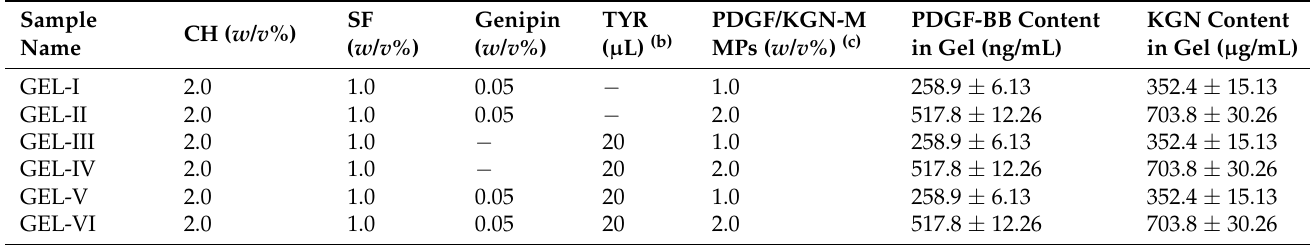
Table 3. Parameters for hydrogels containing PDGF/KGN-M microspheres (a)